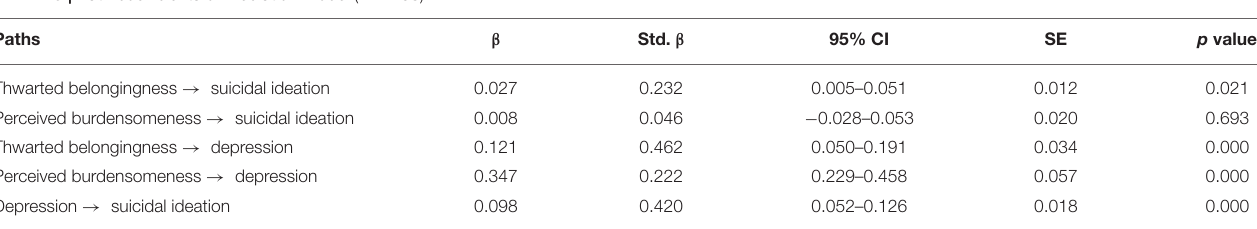
TABLE 3 | Path coefficients of mediation model ( n =